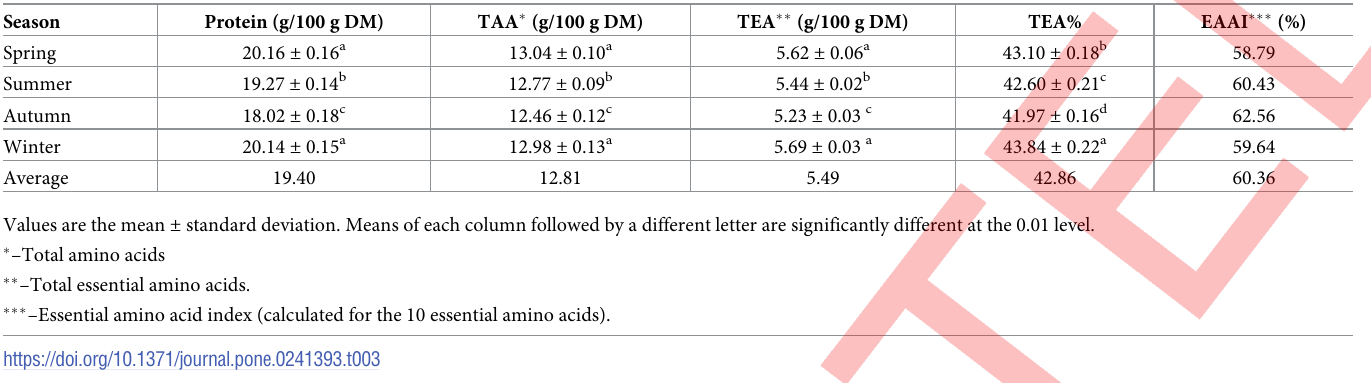
Table 3. Crude protein, total amino acid and essential amino acid composition of bee pollen.